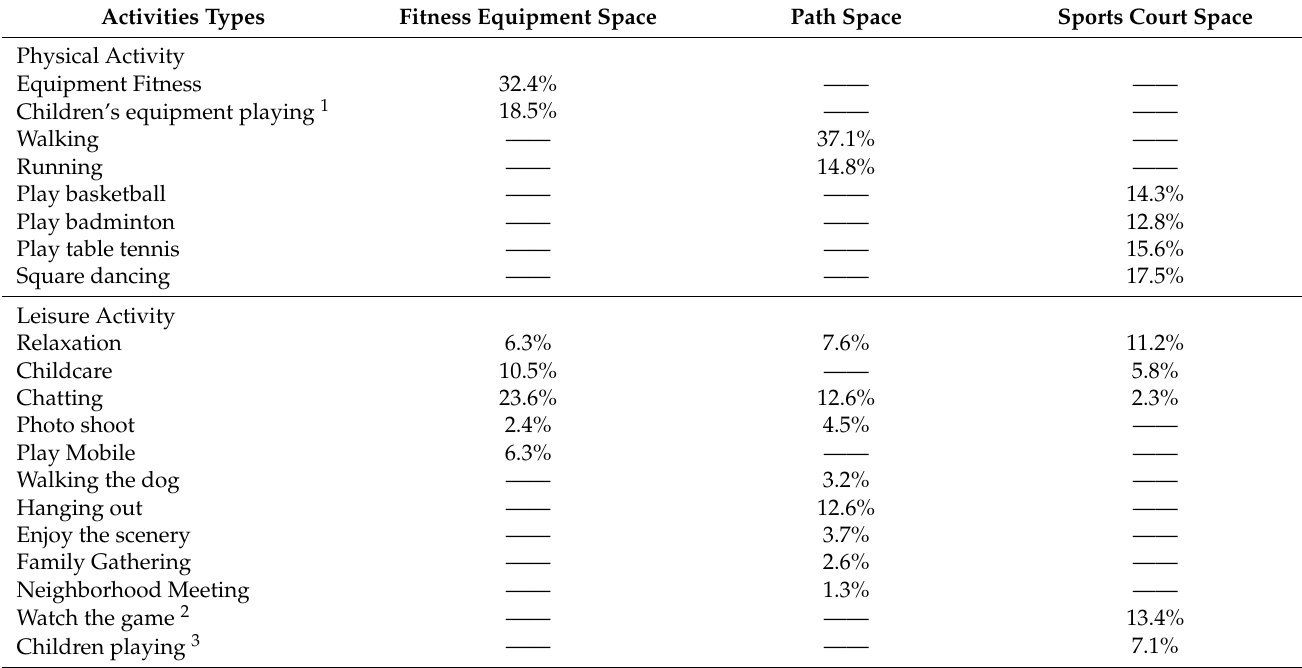
Table 3. Proportion of activities in three types of spaces in community sports parks.